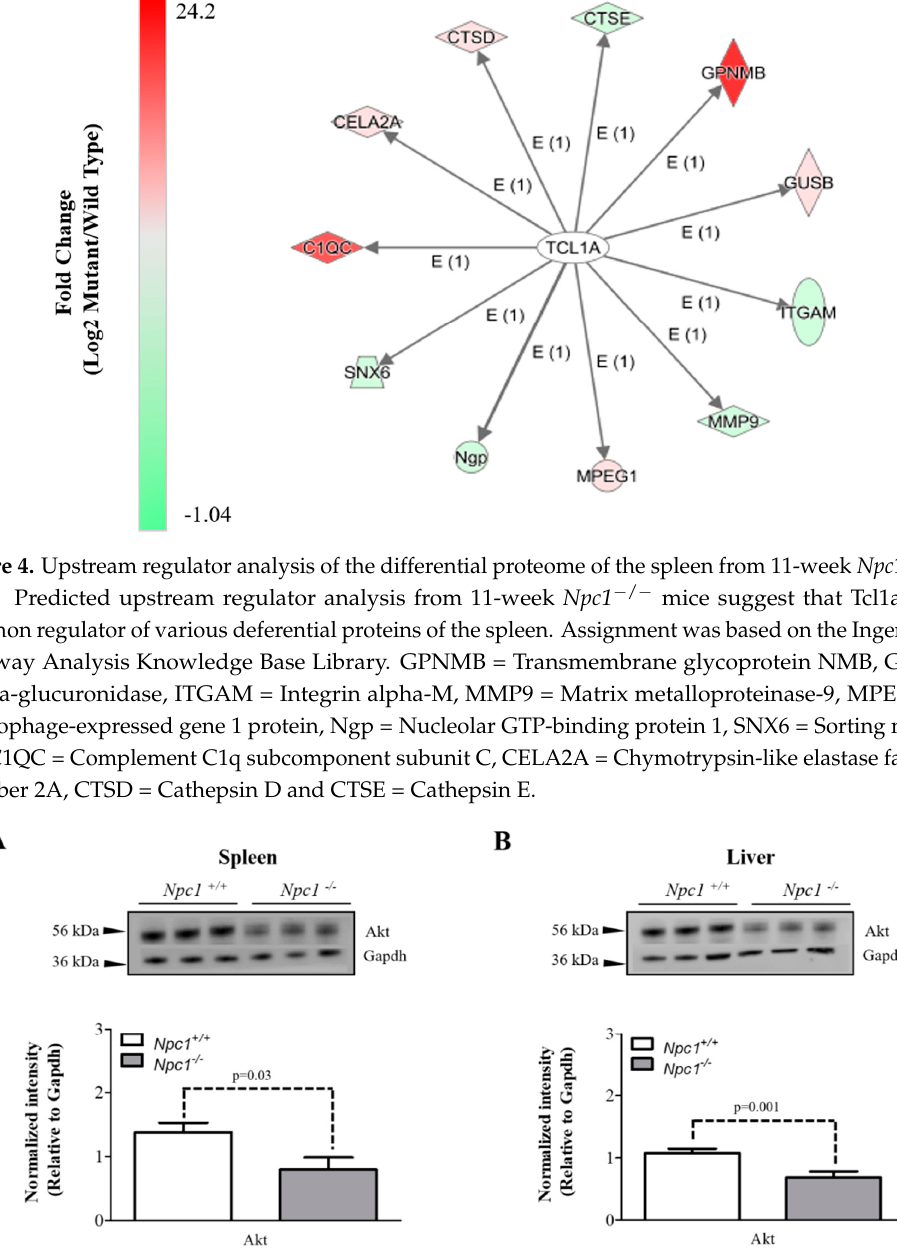
Figure 5. Western blot analysis of Akt in spleen and liver tissue of 11-week Npc1 +/+ and Npc1 − / − mice. Protein lysates from the spleen and liver of 11-week Npc1 +/+ and Npc1 − / − mice (N = 3 each genotype) were subject to electrophoresis and Western blotting. Data analysis revealed decreased expression of Akt in both the ( A ) spleen and ( B ) liver of Npc1 − / − mice. Data is reported as relative to Gapdh.